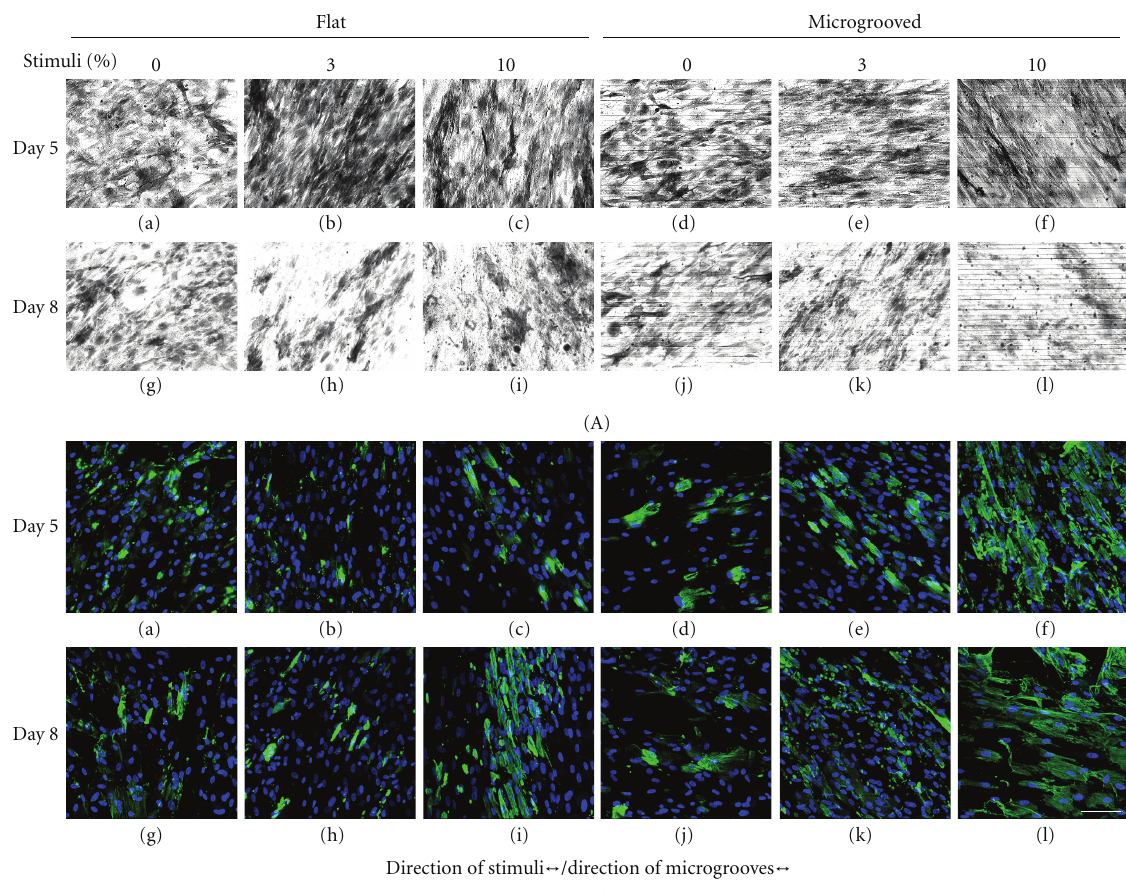
Figure 4: Staining of ALP and α -SMA. The expressions of ALP and α -SMA in MSCs on day 5 ((a)–(f)) and day 8 ((g)–(l)) are presented in (A) and (B), respectively. The expression of ALP was substantial on day 5 when 3% of straining was imposed on the flat surface ((A)(b)). The expression of α -SMA on the microgrooved surface was enhanced more than on the flat surface. In particular, the highest expression of α -SMA was observed when MSCs were under 10% strain on the microgrooved surface. (All photographs were taken at same magnification level; scale bar = 100 μ